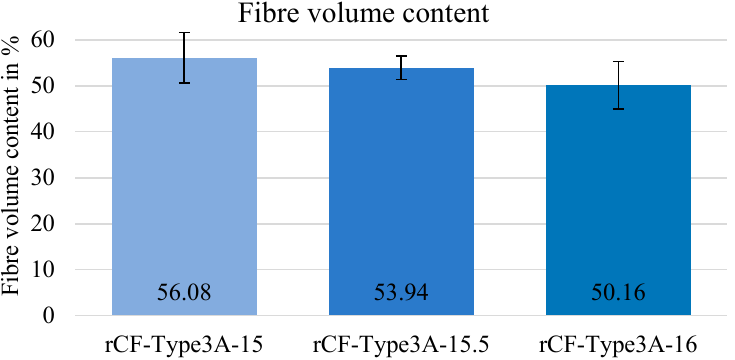
Figure 5. Measured fibre volume content by ashing using material made from HY6 (rCF-type 3), Indexation: rCF type 3 with sizing A (titanium oxide-based sizing)—stitch length in MLG (15/15.5/16 mm).